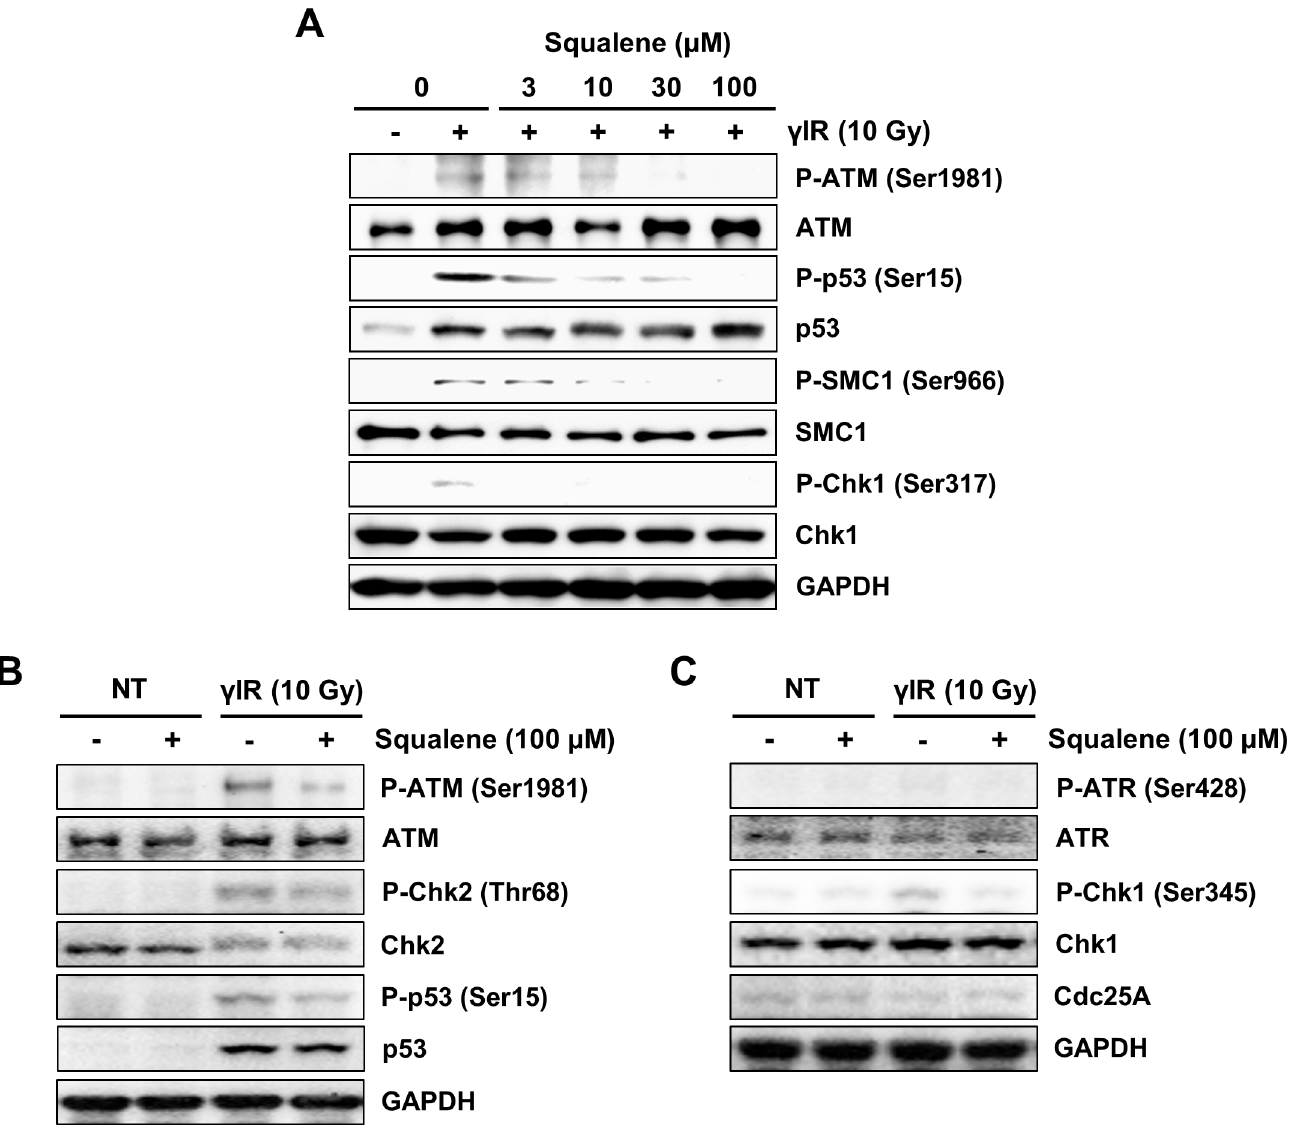
Fig 3. Squalene inhibits phosphorylation of checkpoint proteins after γ IR. A549 adenocarcinoma cells were pre-incubated with or without squalene (3, 10, 30, and 100 μ M) for 4 h followed by irradiation with γ IR (10 Gy) and incubated at 37°C for 3 h. (A) Concentration-dependency of squalene on ATM, p53, SMC1, and Chk1 activation was examined by immunoblot analysis. The effect of squalene (100 μ M) on the (B) ATM-Chk2-p53 pathway and (C) ATR-Chk1-Cdc25A pathway was examined by immunoblot analysis. GAPDH was used as a loading